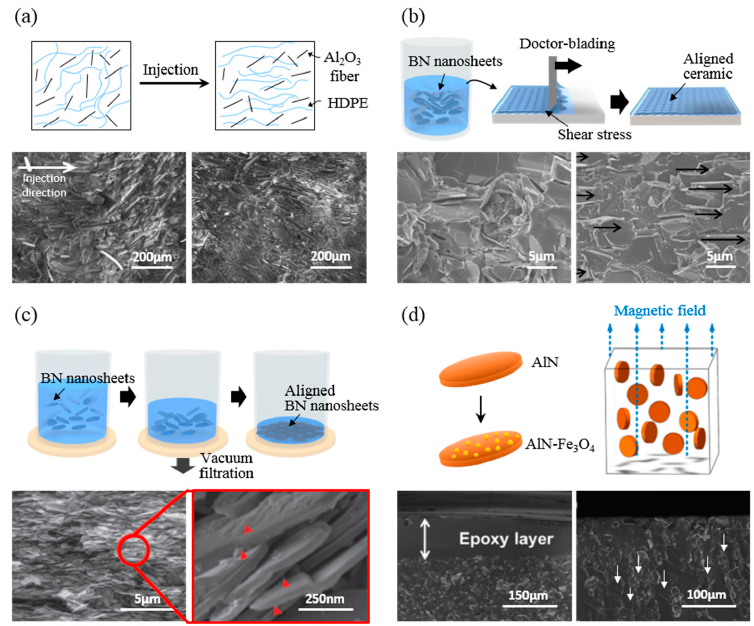
Figure 3. Schematic illustration and their SEM images of aligned ceramic fillers in a polymer matrix. ( a ) Schematic illustration for the orientation of Al 2 O 3 fibers in high-density polyethylene (HDPE) formed by directional shear injection force and cross-sectional SEM images of the Al 2 O 3 composite [23]. Reprinted with permission from [23] Copyright (2007) John Wiley and Sons. ( b ) Schematic illustration of the process for a BN/polyvinyl alcohol (PVA) composite film (20 vol % of BN) whereby shear stress of meniscus is applied with doctor blading, and its cross-sectional SEM images [56]. Reprinted with permission from [56] Copyright (2015) American Chemical Society. ( c ) Schematic illustration of the preparation of nacre-like BN/PVA composite paper (6 wt % of PVA) aligned by vacuum filtration force, and its cross-sectional SEM images [57]. Reprinted with permission from [57] Copyright (2015) Royal Society of Chemistry. ( d ) Anisotropic assembly of AlN pallets coated with Fe 3 O 4 . The surface modified filler is sensitive to a magnetic field. It is aligned as shown in the schematic. Cross-sectional SEM images of randomly dispersed AlN/epoxy without magnetic force (left) and AlN-Fe 3 O 4 /epoxy aligned by magnetic field (right) [53,58] are shown. {( d )(upper): Reprinted with permission from [53] Copyright (2016) Elsevier. ( d )(bottom): Reprinted with permission from [58] Copyright (2015) American Chemical